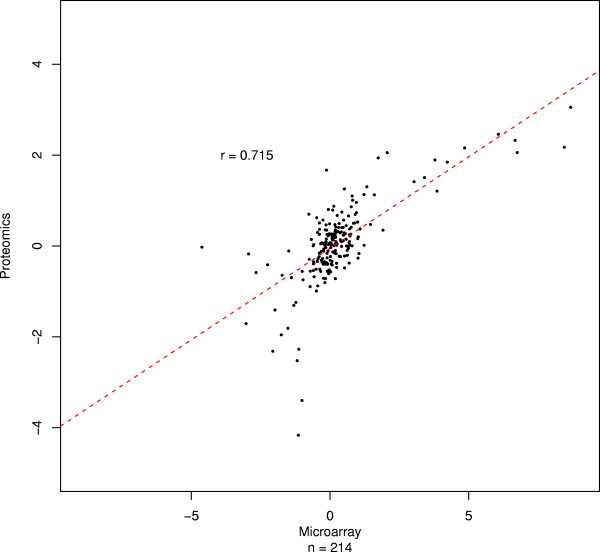
High correspondence between plus2 array and quantitative proteomics data. Each point corresponds to a matched transcript-protein pair using GeneCruiser annotation. X and Y axes: fold-changes between MCF7 and MCF10A for the microarray data and the quantitative proteomics data, respectively. When more than one matching probeset was found, the mean value was calculated, protein level averages were calculated by ProGroup. r: Pearson correlation. n: number of data points. No error bars are shown since these data are not provided by ProGroup.